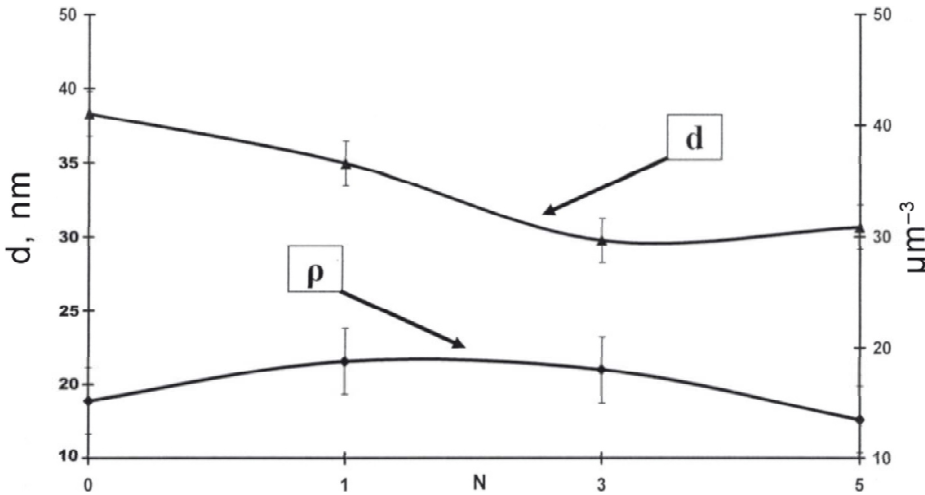
Fig. 14. Dependence of the average size ( d ) and volume density (  ) of the nanoparticles of the crystalline phase in the initial partially crystallized alloy Ni tion ( T =